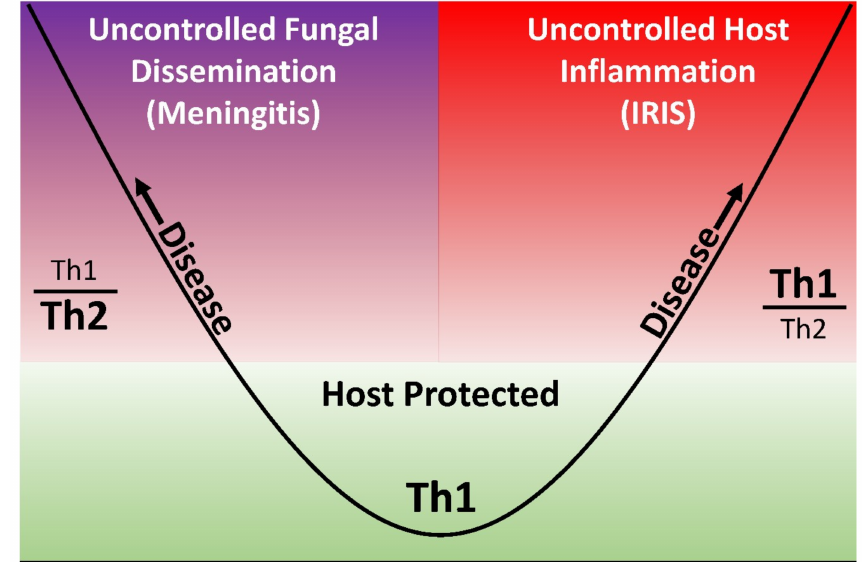
Figure 3. Damage-response parabolic framework in cryptococcal meningitis (adapted from Pirofski